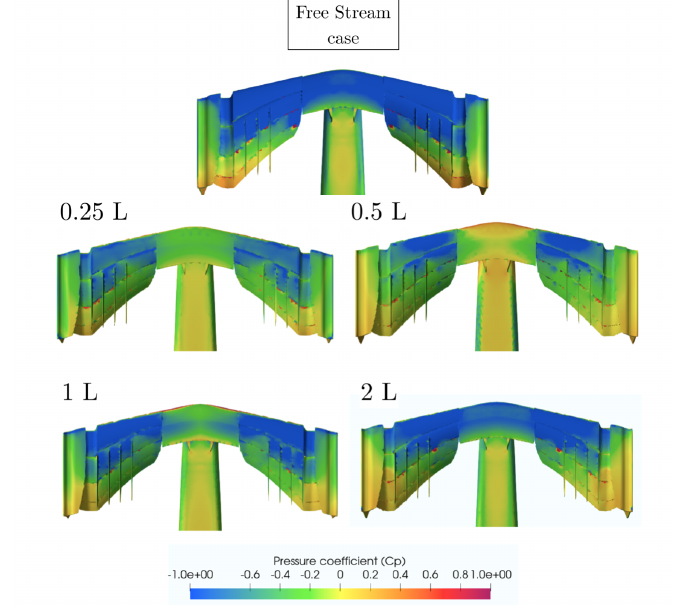
Figure 17. Pressure coefficient distribution on the front wing of the second car at a distance of 0.25 L, 0.5 L, 1 L, and 2 L as compared to the free stream